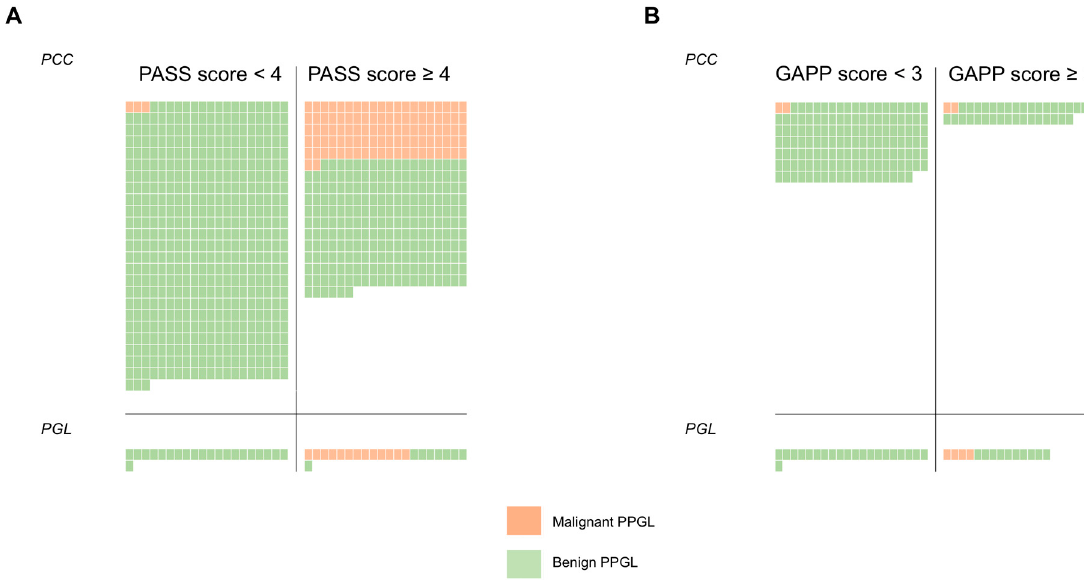
Figure 2. Schematic overview of the ( A ) PASS and ( B ) GAPP meta-analyses outcome in pheochromocytoma (PCC) and abdominal paraganglioma (PGL). Each tumor sample is represented by a square, in which green color indicates a benign tumor as according to the definition by each study. Orange squares denote cases defined as malignant. The left column of each classification system signifies number of cases with low algorithm scores, whereas the right column contains cases with scores ≥ 4 (PASS) and ≥ 3 (GAPP). As demonstrated here, both algorithms exhibit excellent sensitivity but reduced specificity towards malignant cases. These analyses indicate that low PASS and GAPP scores almost always are associated with a benign clinical course.